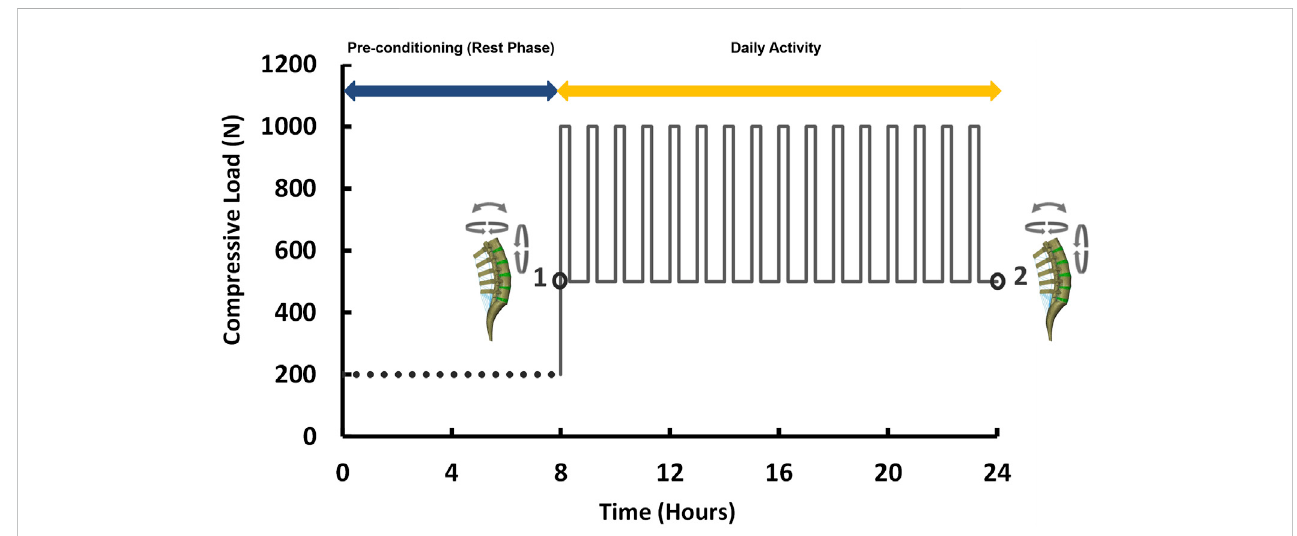
FIGURE 2 Loading scenario of the daily cyclic loading (Flexion, extension, lateral bending, and axial rotation moments of 10 N m were applied at points 1 and 2).